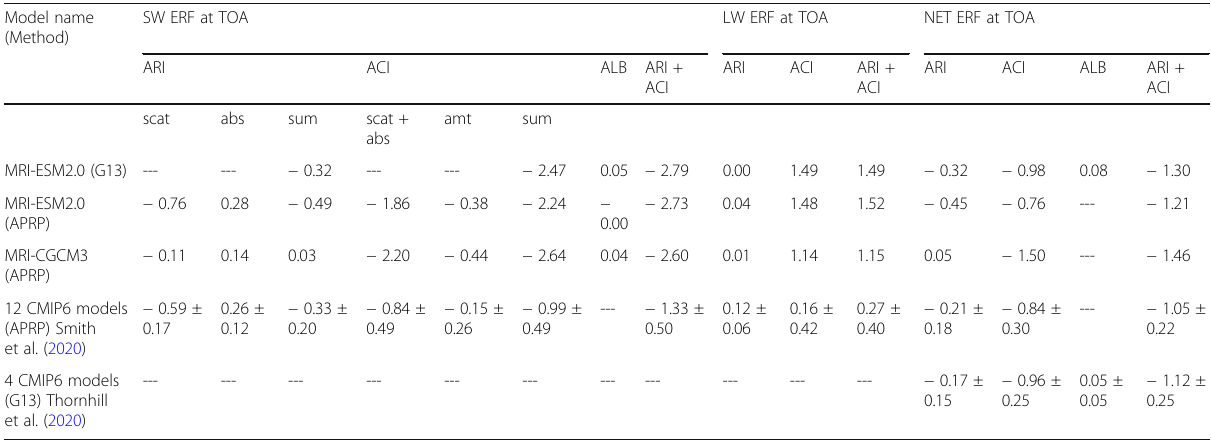
Table 4 Global annual mean effective radiative forcings of aerosols estimated by different methods and other